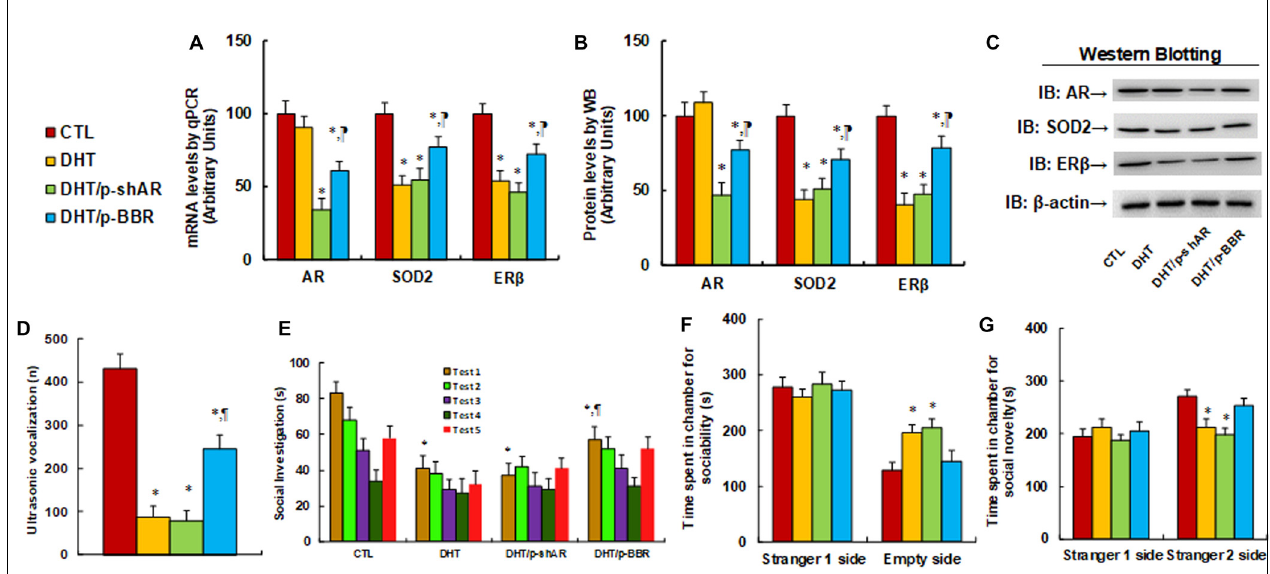
FIGURE 5 | Postnatal BBR treatment ameliorates prenatal DHT exposure-induced ALB in offspring, while postnatal shAR treatment does not affect. The 2-month female rats received either CTL or DHT treatment during their pregnancy, and the subsequent 2-month old male offspring from DHT group received either shAR lentivirus infusion in the amygdala (DHT/p-shAR) or DHT with BBR injection (DHT/p-BBR) for 1 week, and then the male offspring were used for ALB analysis followed by a biomedical analysis of the isolated amygdala. (A) The mRNA levels for gene expression of AR, ER β and SOD2, n = 4. (B) Quantitation of protein levels, n = 5. (C) The representative pictures for western blotting for (B) . (D) Ultrasonic vocalization, n = 9. (E) Social recognition, seconds spent socially investigating a conspecific [same conspecific in tests 1–4; novel conspecific in test 5 (a new stimulus rat was introduced)], n = 9. ∗ P < 0.05, vs. CTL group; ¶ P < 0.05, vs. DHT group. (F,G) Three-chambered social tests, n = 8. (F) Time spent in the chamber for sociability. (G) Time spent in the chamber for social novelty. ∗ P < 0.05, vs. CTL group. Data were expressed as mean ± SEM.